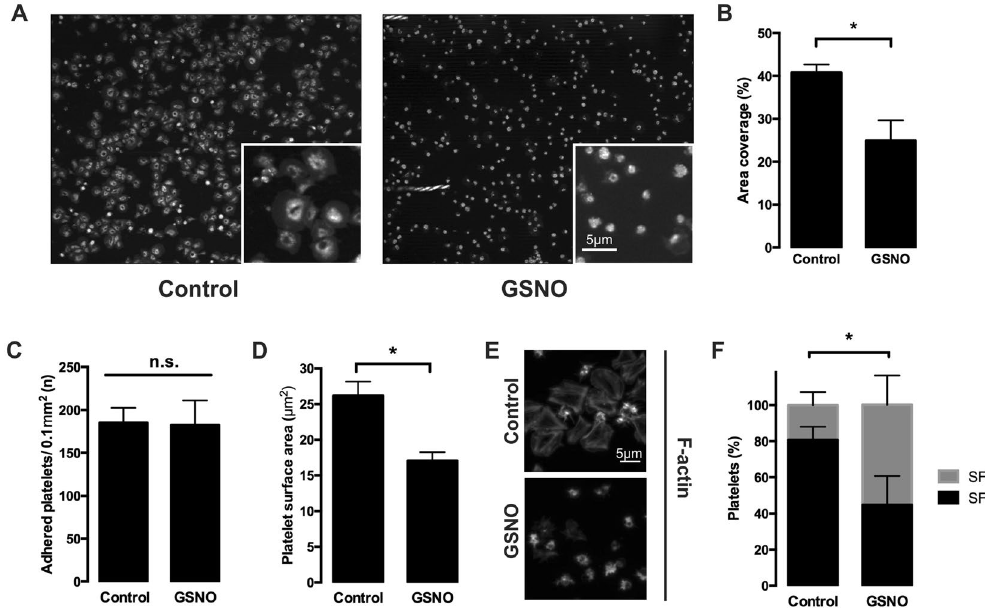
Figure 7. Perfusion of NO over adhered platelets under shear stress reduces platelet surface coverage. Whole human blood anticoagulated with PPACK (10 µ M) and labelled with DiOC 6 (10 µ M) was flowed over fibrinogen-coated slides (300 µ g/ml) for 2 minutes at 1000 s − 1 to allow platelets to adhere spread and form small aggregates. Aggregates and spread platelets were then perfused with either buffer (control) or GSNO (100 nM) for a further 20 minutes. Platelets were fixed with 4% paraformaldehyde for 30 minutes followed by further DiOC 6 or phalloidin staining. Images were acquired via the Zeiss Axio observer confocal microscope at x63 magnification. Percentage area coverage was analysed using ImageJ. ( A ) Representative images of small aggregates and spread platelets perfused with buffer (left panel) or GSNO (right panel) for 20 minutes; ( B ) Quantification of surface area coverage; ( C ) Quantification of number of adhered platelets; ( D ) Quantification of the average platelet surface area under high shear conditions; ( E ) Representative images of the actin cytoskeleton of spread platelets under high conditions after perfusion with buffer or GSNO for 20 minutes; ( F ) identification of platelets lacking stress fibres (SF − ) or containing stress fibres (SF + ). Data represents 3 repeats. Error bars represent S.E.M. with significance ( * ) defined as p < 0.05. Scale bar is representative of 5 μ